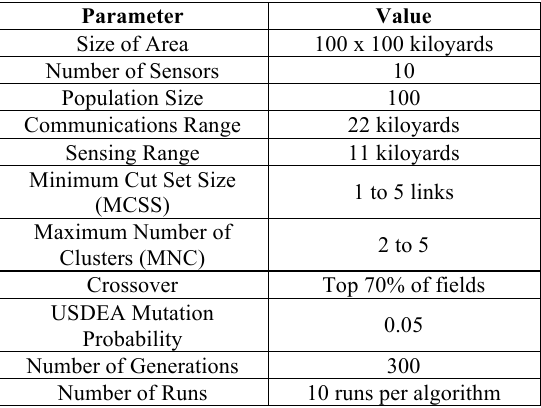
Table 1 records the parameters used for each